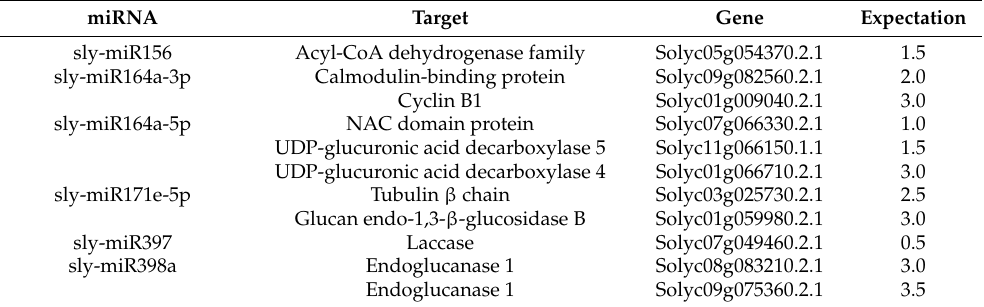
Table 1. Target gene prediction of selected tomato miRNAs.